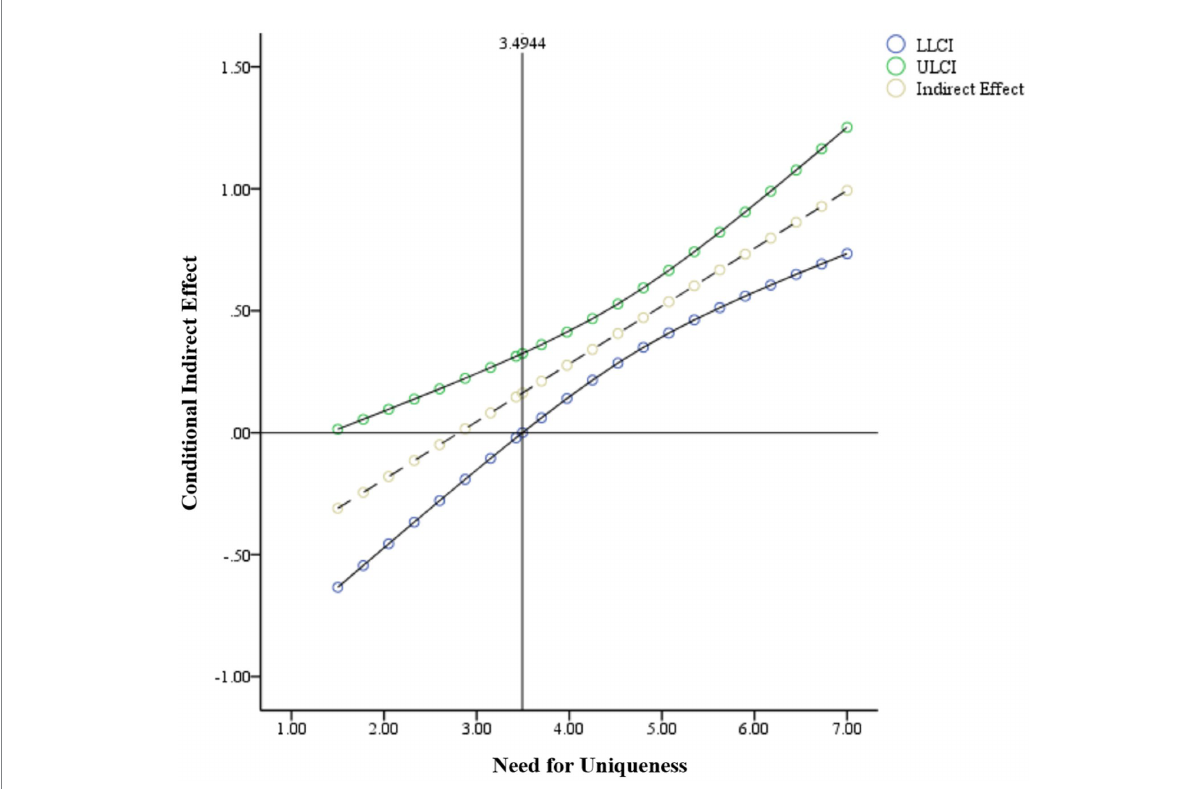
FIGURE 2 The conditional indirect effect of scarcity appeal on purchase intention via perceived uniqueness (moderator: need for uniqueness). The horizontal line denotes an indirect effect of zero; the vertical lines represent the boundary of the region of